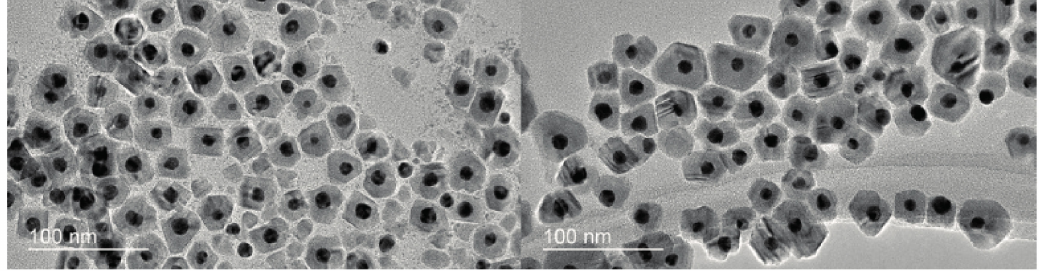
Figure 17. TEM micrographs of Au/Cu 2 FeSnS 4 core/shell NPs (Reprinted with permission from Reference [173] Copyright (2015) published by the American Chemical